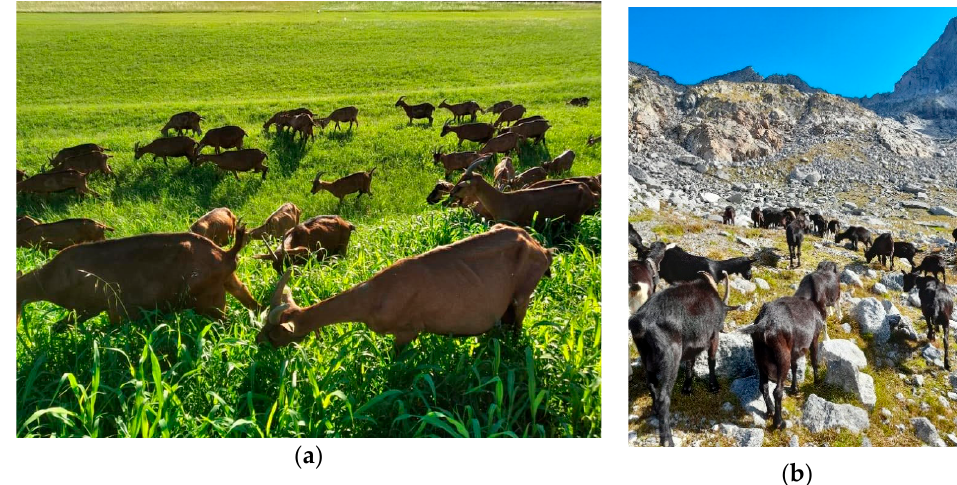
Figure 1. Camosciata delle Alpi ( a ) and Verzaschese ( b ) goats during free grazing (by courtesy of Mrs. Paola Rossi and Mr. Franco Del Bondio, respectively).